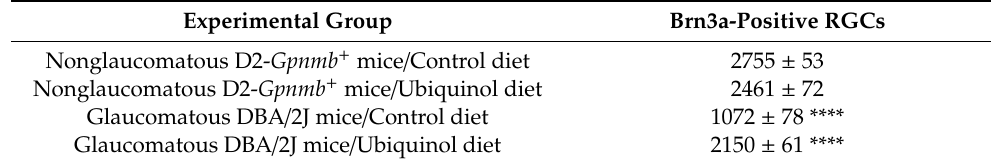
Table 1. E ff ect of ubiquinol on Brn3a-positive RGCs in the middle area of glaucomatous DBA / 2J retinas. Experimental